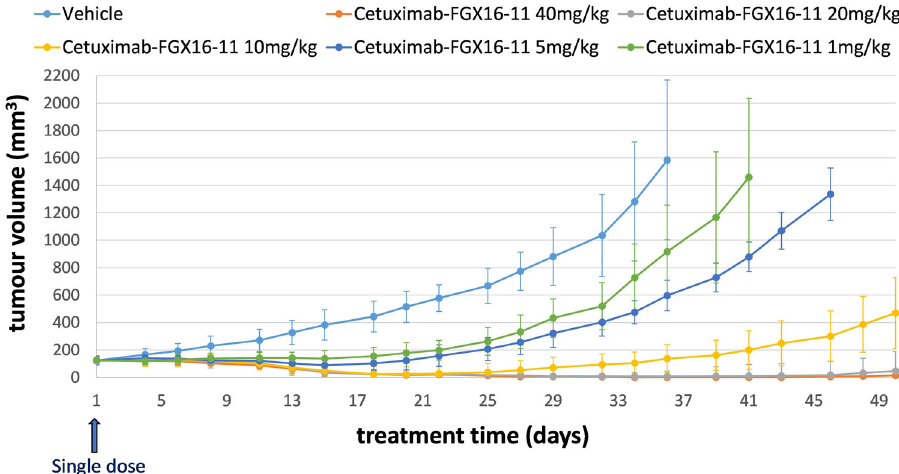
Fig. 9 Results of an in vivo ef fi cacy study of Cetuximab-(FGX16-11) (10) in a Human Tumour Xenograft experiment based on BALB/c mice and the EGFR-expressing human colon cancer cell line SW-48 at single doses ranging from 1 mg/kg to 40 mg/kg. The ADC was active at all levels including the lowest 1 mg/kg (single dose), which provided tumour suppression out to approximately three weeks; n = 6 mice per